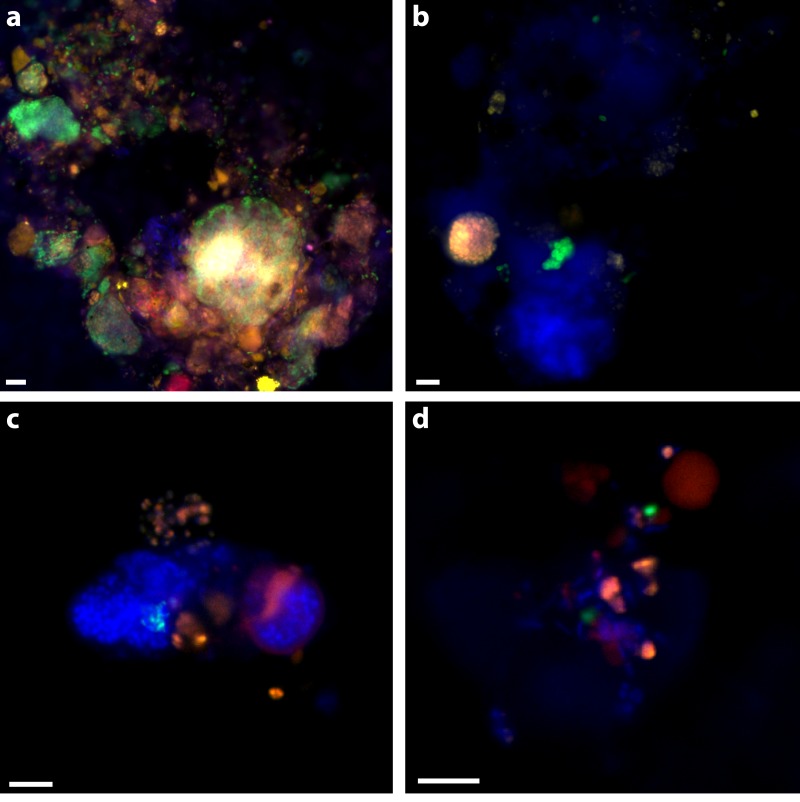
Examples of triple CARD-FISH hybridized aggregates.Triple CARD-FISH hybridization using bacteria and archaea probes targeting DSS_658 (A), Gam42a (B), CF319A/B (C), and Epsi404 (D) in green FITC, with ANME1-350 in red and MSMX-Eel_932 in yellow for all. Scale bar 5 µm for all. DAPI stain in blue.